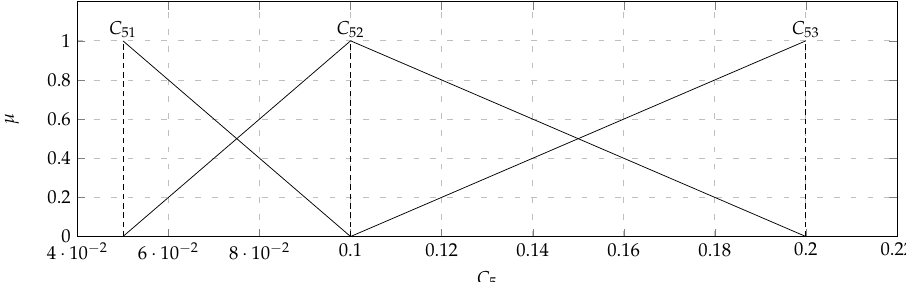
Figure 12. Visualization of Assists per round ( C 5 ) and triangular fuzzy numbers 0.05 ( C 51 ), 0.10 ( C 52 ), and 0.20 ( C 53